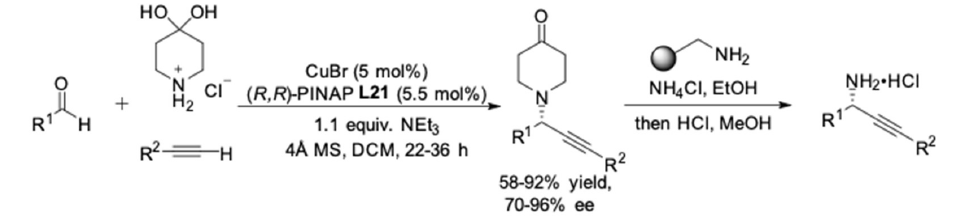
Figure 19. AA 3 -couplings of 4-piperidone·HCl.